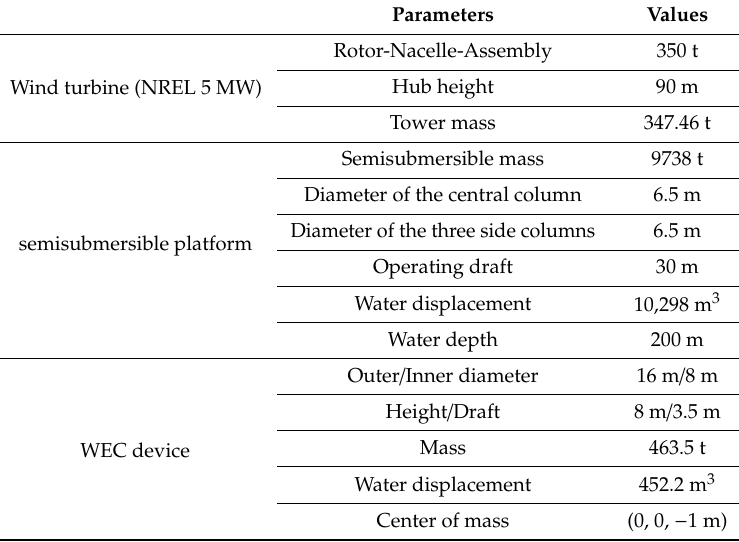
Table 1. Main design parameters of the combined